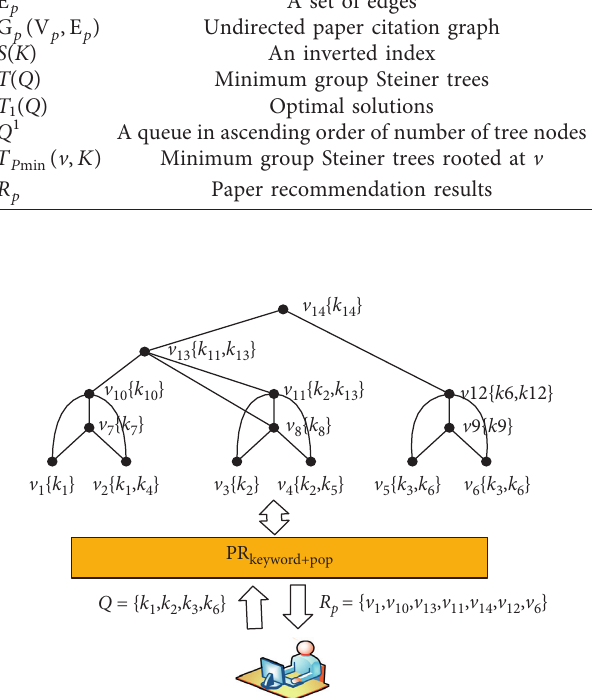
Figure 4: An example of PR